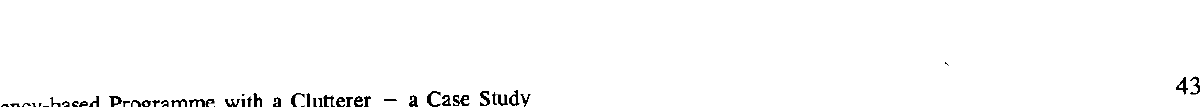
Table 5(10 Analysis of Changes in Laymen's Judgements of stuttering rate and monotony in the Speech Sample from the Pre- to the Post-Therapeutic Recording